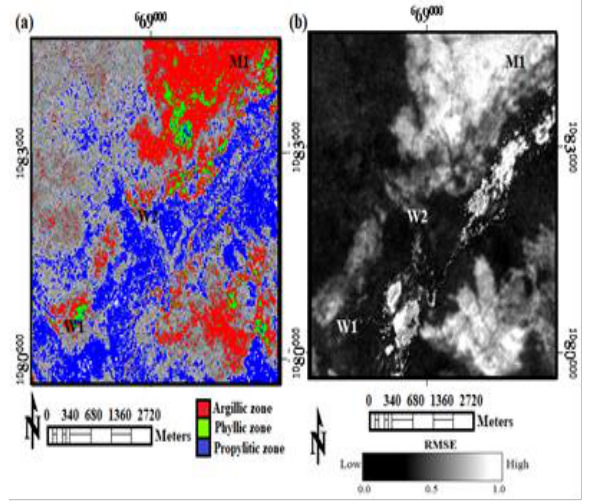
Figure 5: (a) LSU subpixel abundance image using library spectra (Wikki roi). (b) RMSE image for image in